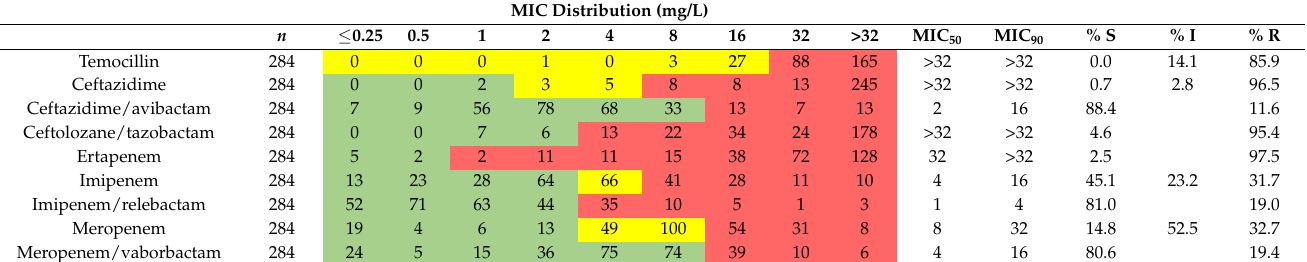
Table 1. MICs distribution for β -lactams and β -lactams/ β -lactamases inhibitors combinations.